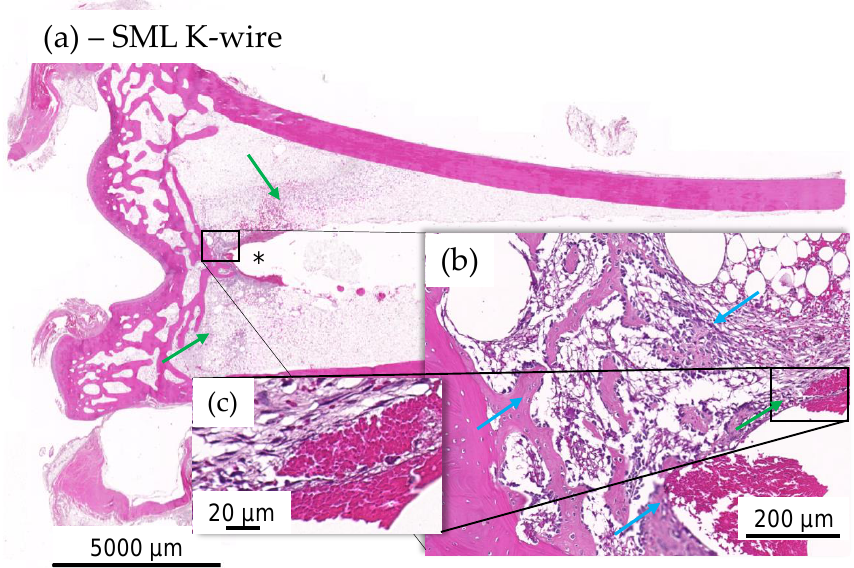
Figure 9. ( a – c ) Histology images of distal tibia of test item animal. No evidence of mild ongoing osteomyelitis along the K-wire in most SML K-wire implanted animal and stabilization was often seen to be more significant in the test item at tip of the K-wire imprint (*). Integration was by means of fibroplasia (green arrows) and new fibrous bone formation at host-implant interface (( b ), blue arrows), devoid of any heterophilic infiltration ( c